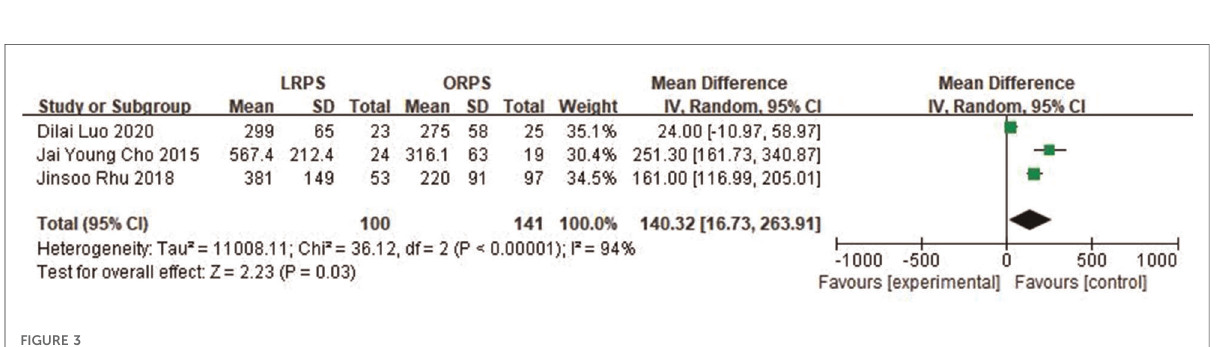
FIGURE 3 Pooled meta-analysis of operative time comparing LRPS with